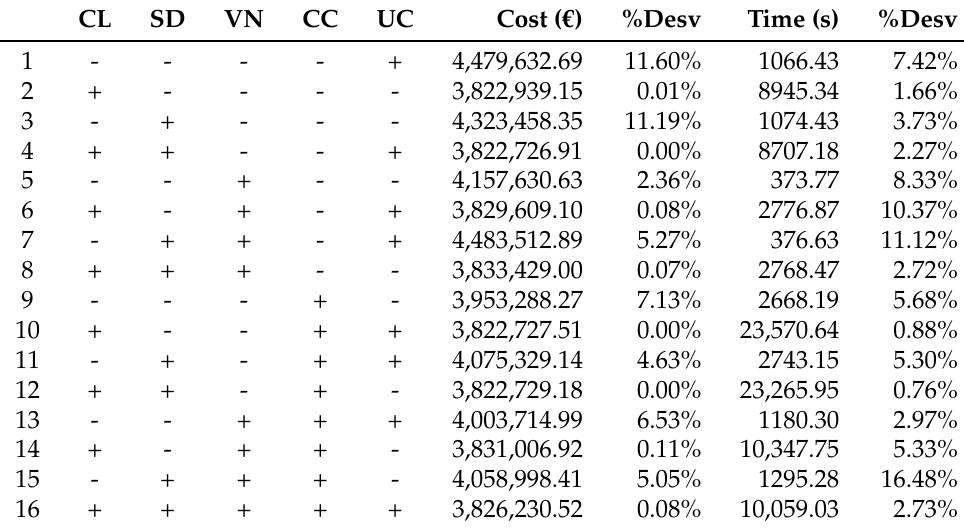
Table 4. Results for each parameter combination of the DoE.